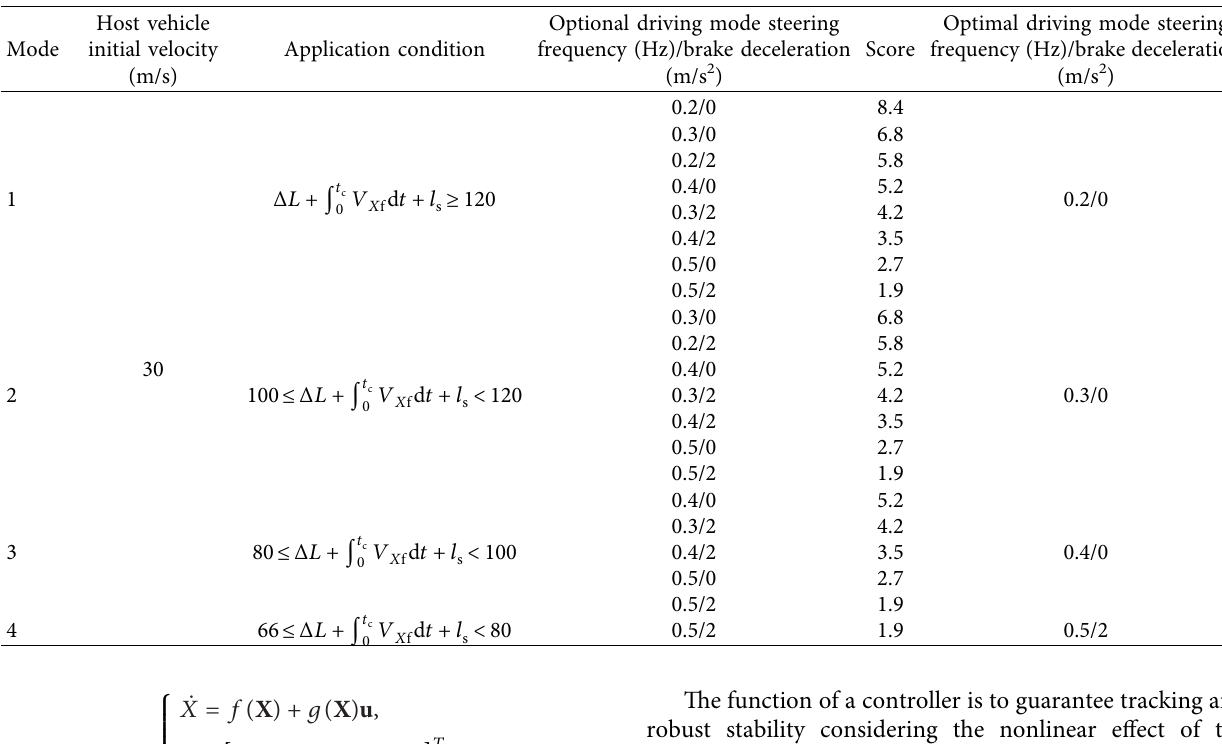
Table 4: Four-level lane-change mode for collision